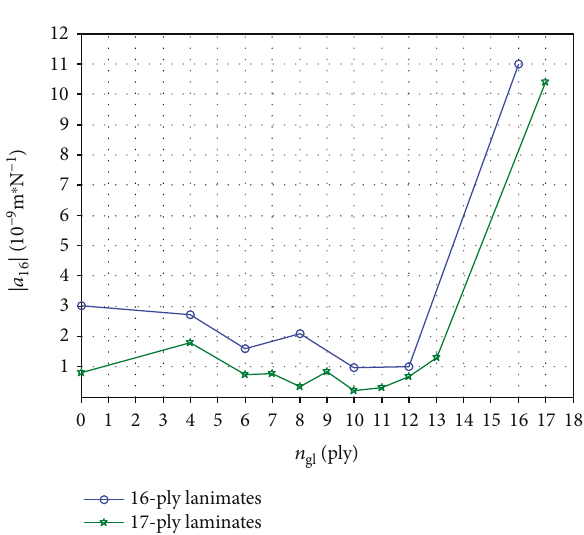
Figure 2: Maximal extension-shear-coupled e ff ect of hybrid laminates with di ff erent proportions of two